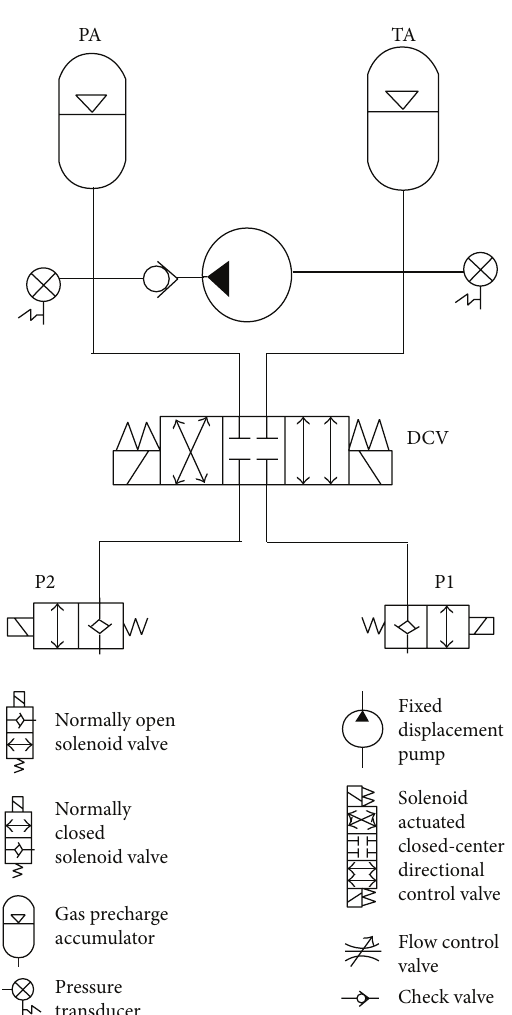
Figure 1: Diagram of the PAS system. Note that P1 and P2 can connect to any hydraulic circuit. In this study, the PAS is connected to a single hydraulic actuator via valve